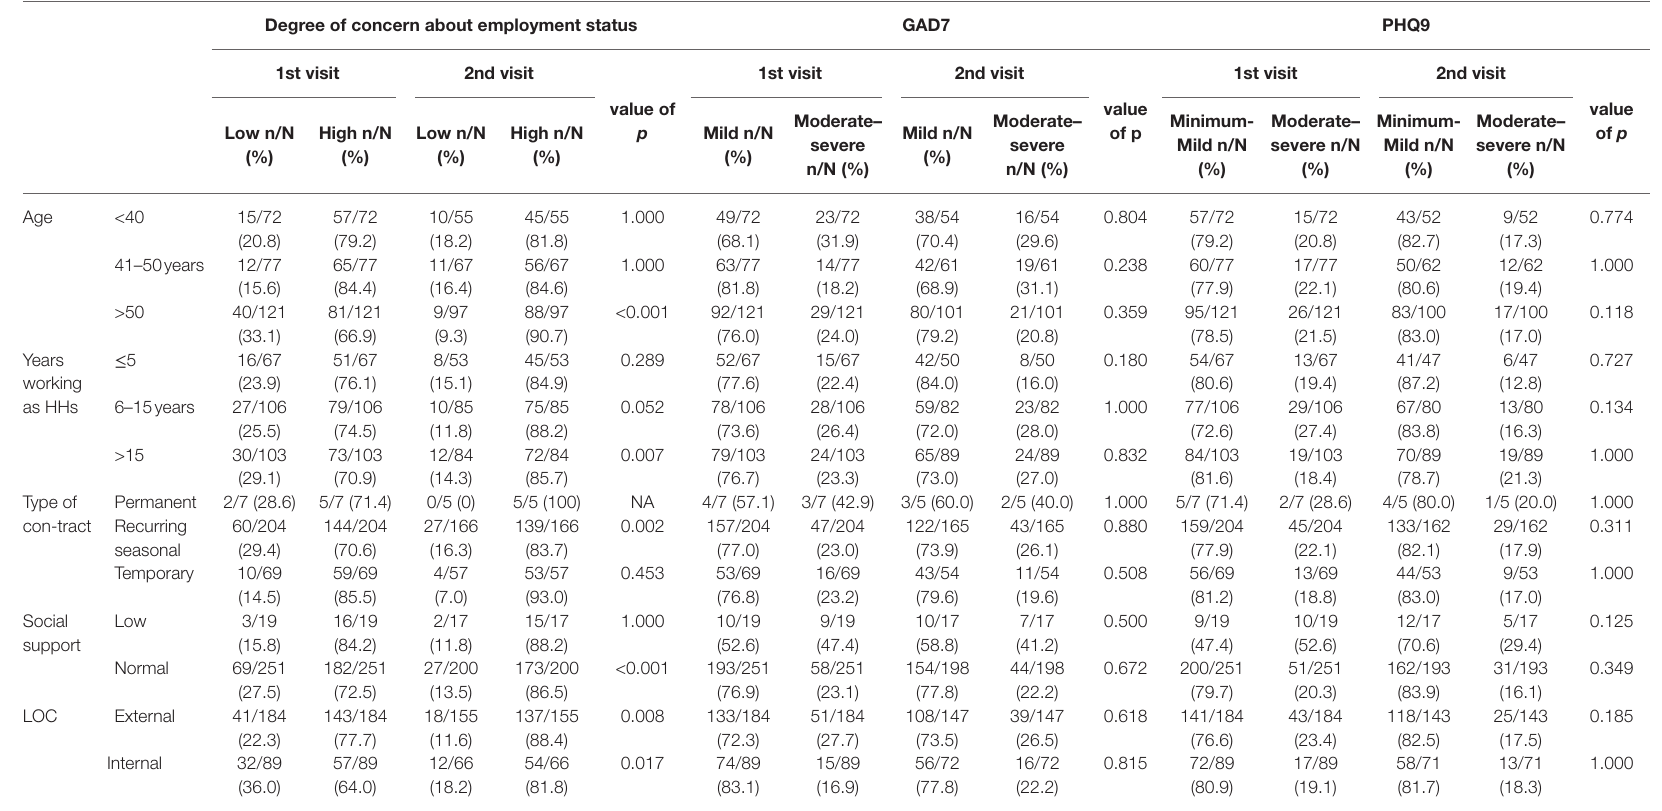
TABLE 2 | Association between hotel housekeepers characteristics (age, years working as HHs, type of contract, social support, and LOC) and degree of concern about employment status and mental